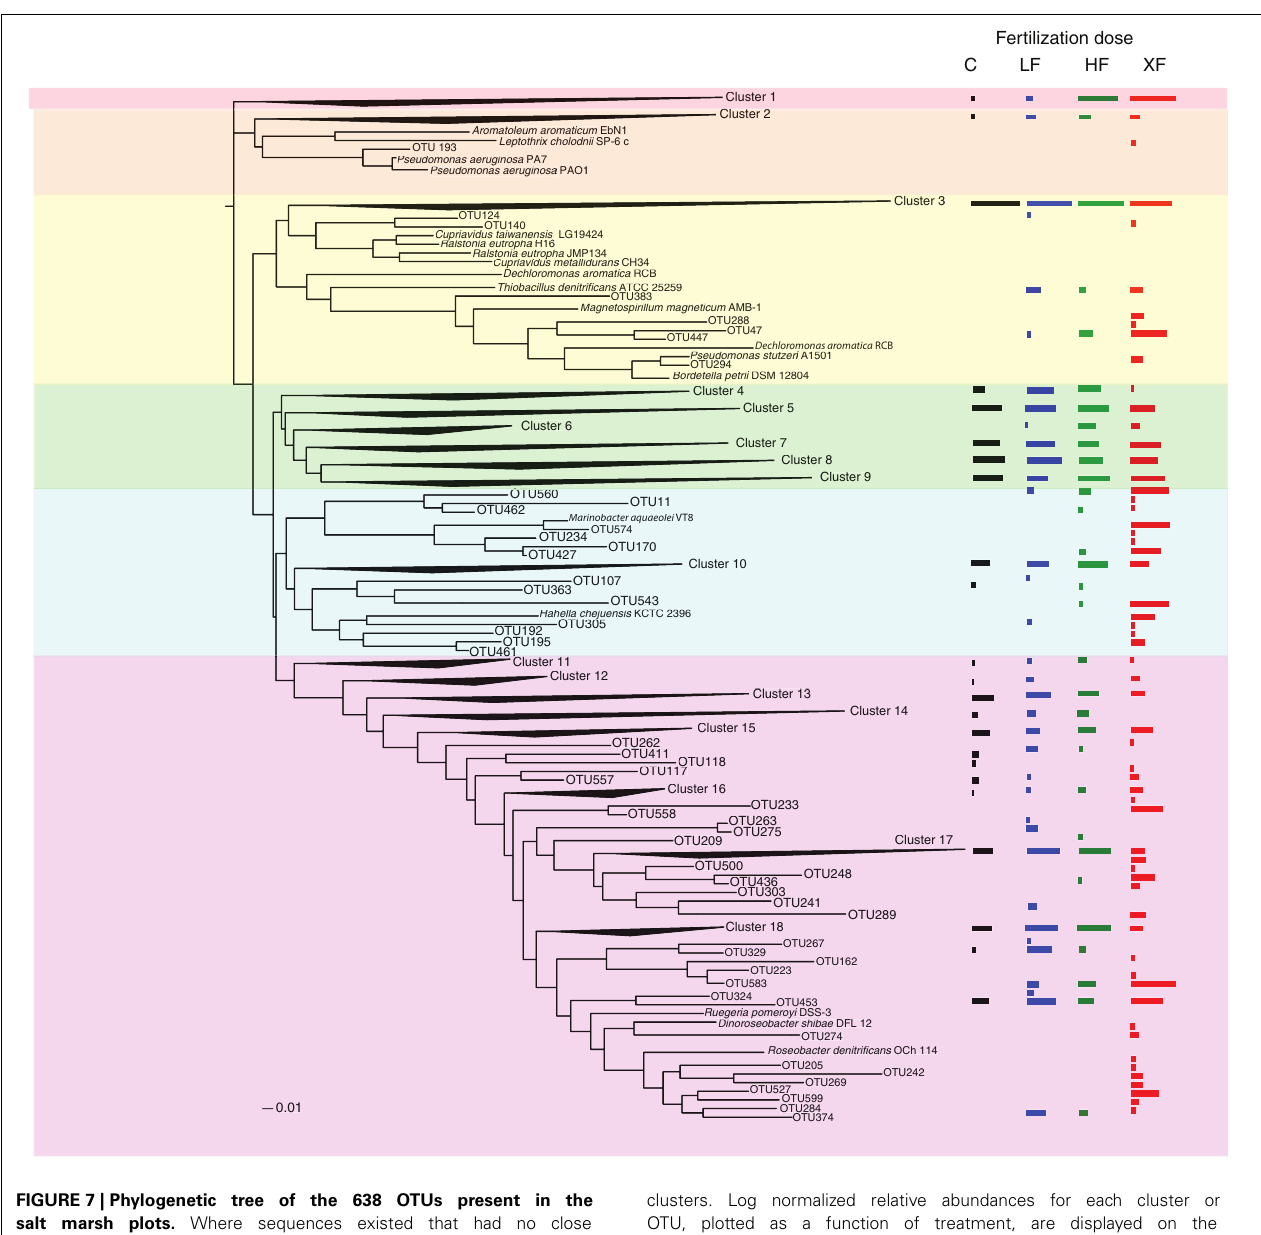
FIGURE 7 | Phylogenetic tree of the 638 OTUs present in the salt marsh plots. Where sequences existed that had no close cultured representatives, the sequences were collapsed into